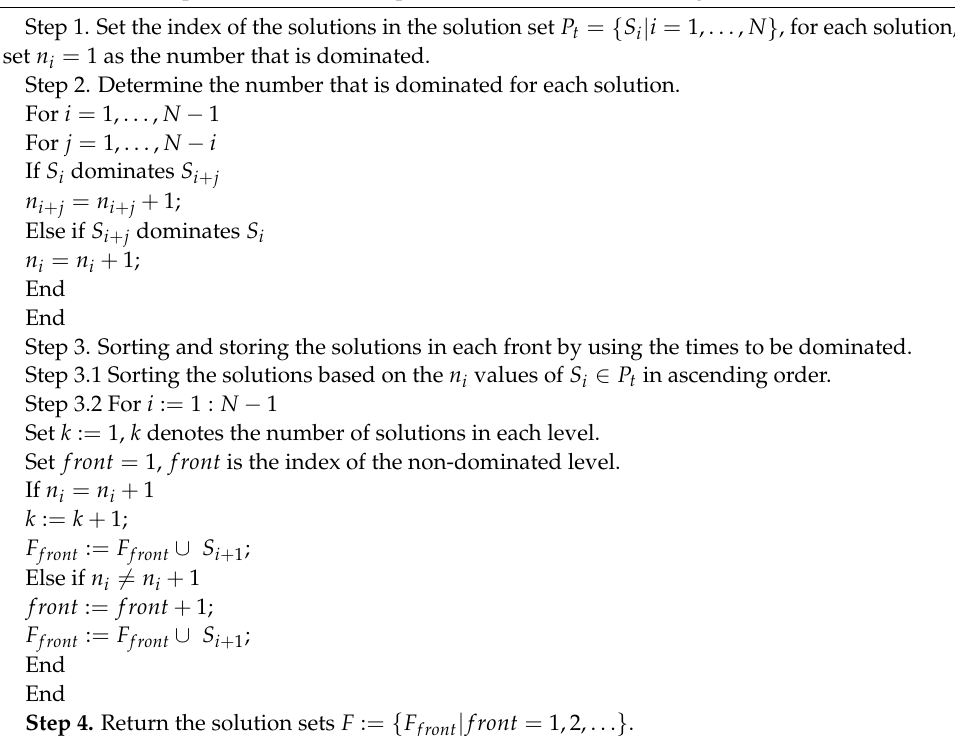
Algorithm 2. The pseudocode of the improved non-dominated sort